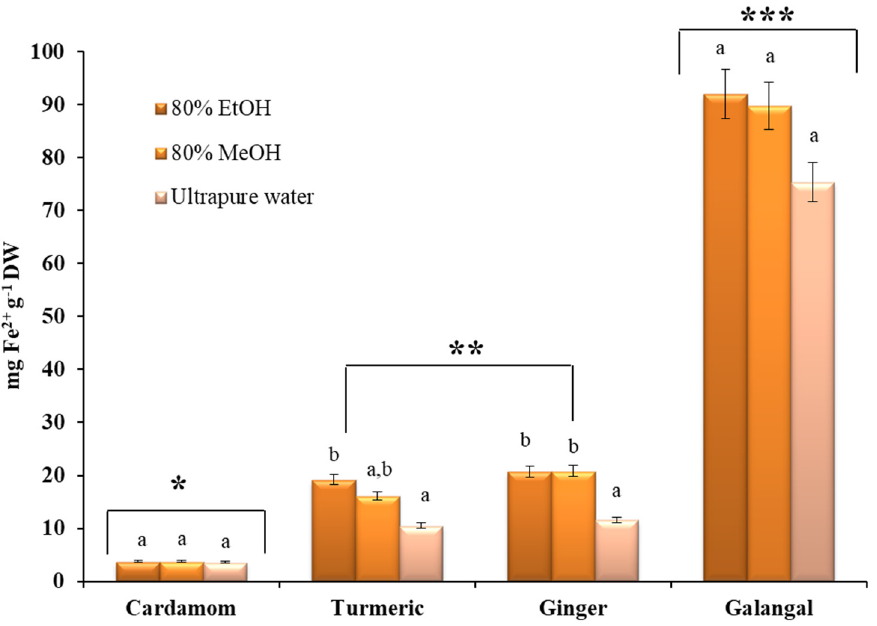
Figure 3. Antioxidant activity of selected Zingiberaceae species expressed as mg Fe 2+ ion equivalents per gram of dry weight (mg Fe 2+ g − 1 DW). All measurements were performed in duplicate. For comparison of the mean values, one-way ANOVA followed by S-N-K post hoc were applied. A different superscript letters (a, b) indicate a statistical difference in the extraction efficiencies of the solvents tested ( p < 0.05), while asterisks indicate statistical differences in antioxidant activity between different plants ( p < 0.05).